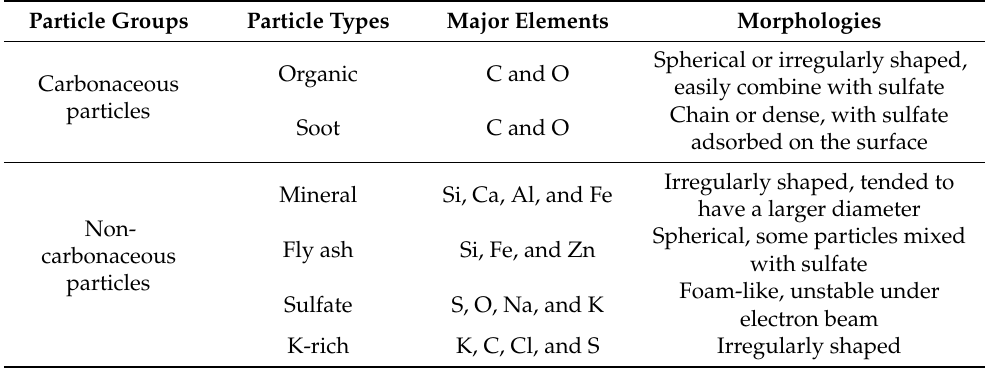
Table 2. Types and characteristics of individual particles in the winter haze of Xi’an during the sampling period.